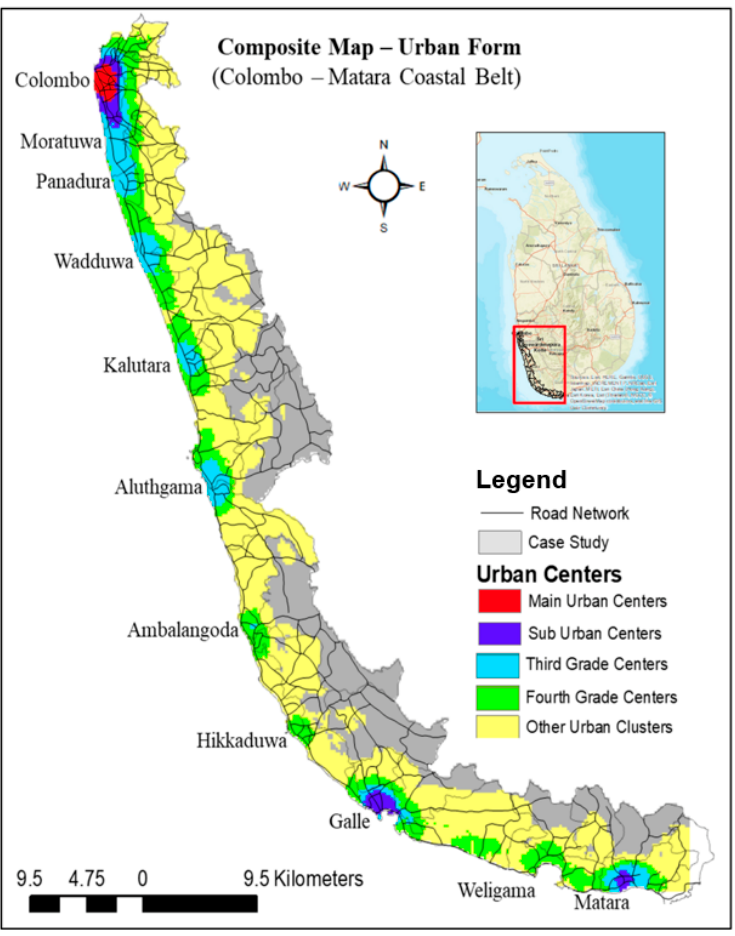
Figure 5. Composite map of urban form-related parameters. Table 7. Identified urban centers and expansion types of adjacent urban patches.